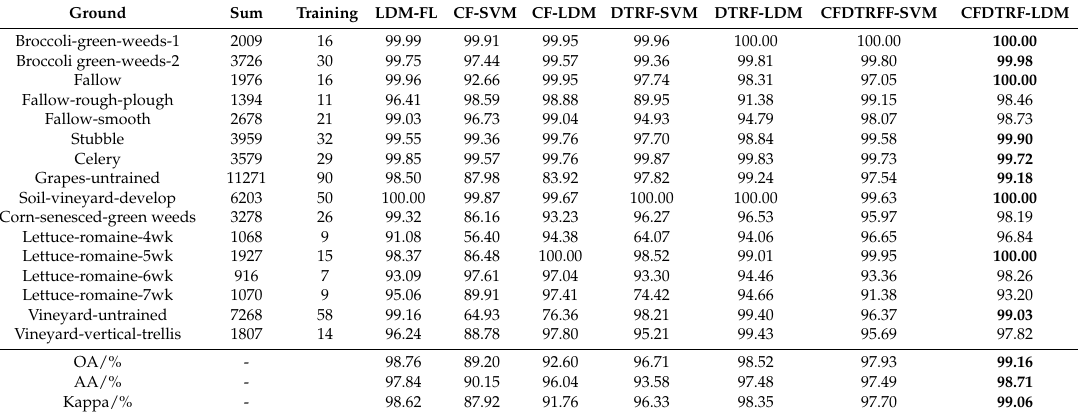
Table 4. Comparison of classification accuracies (in percent) provided by seven methods for Salinas Valley (part B).